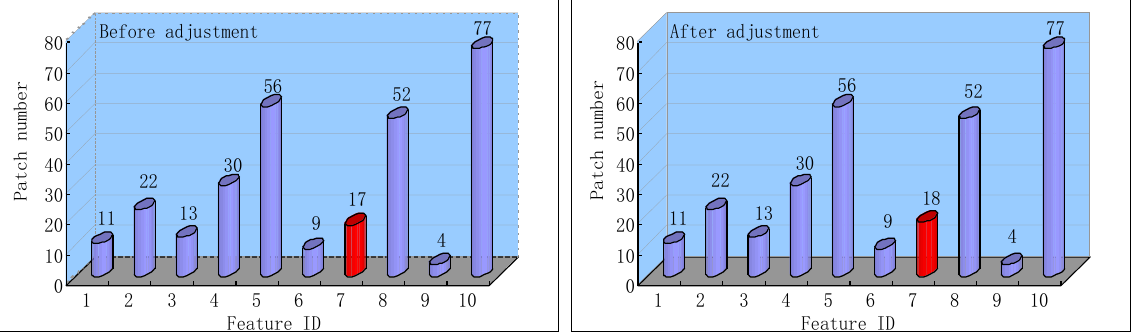
Figure 1. Update of the patch number of a leaf node. The figure is for illustration purposes. A usable system contains larger numbers of features and training